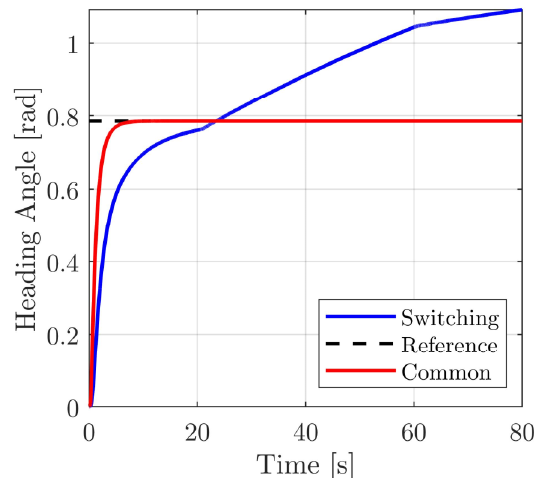
Figure 10. Heading angle of the vehicle.